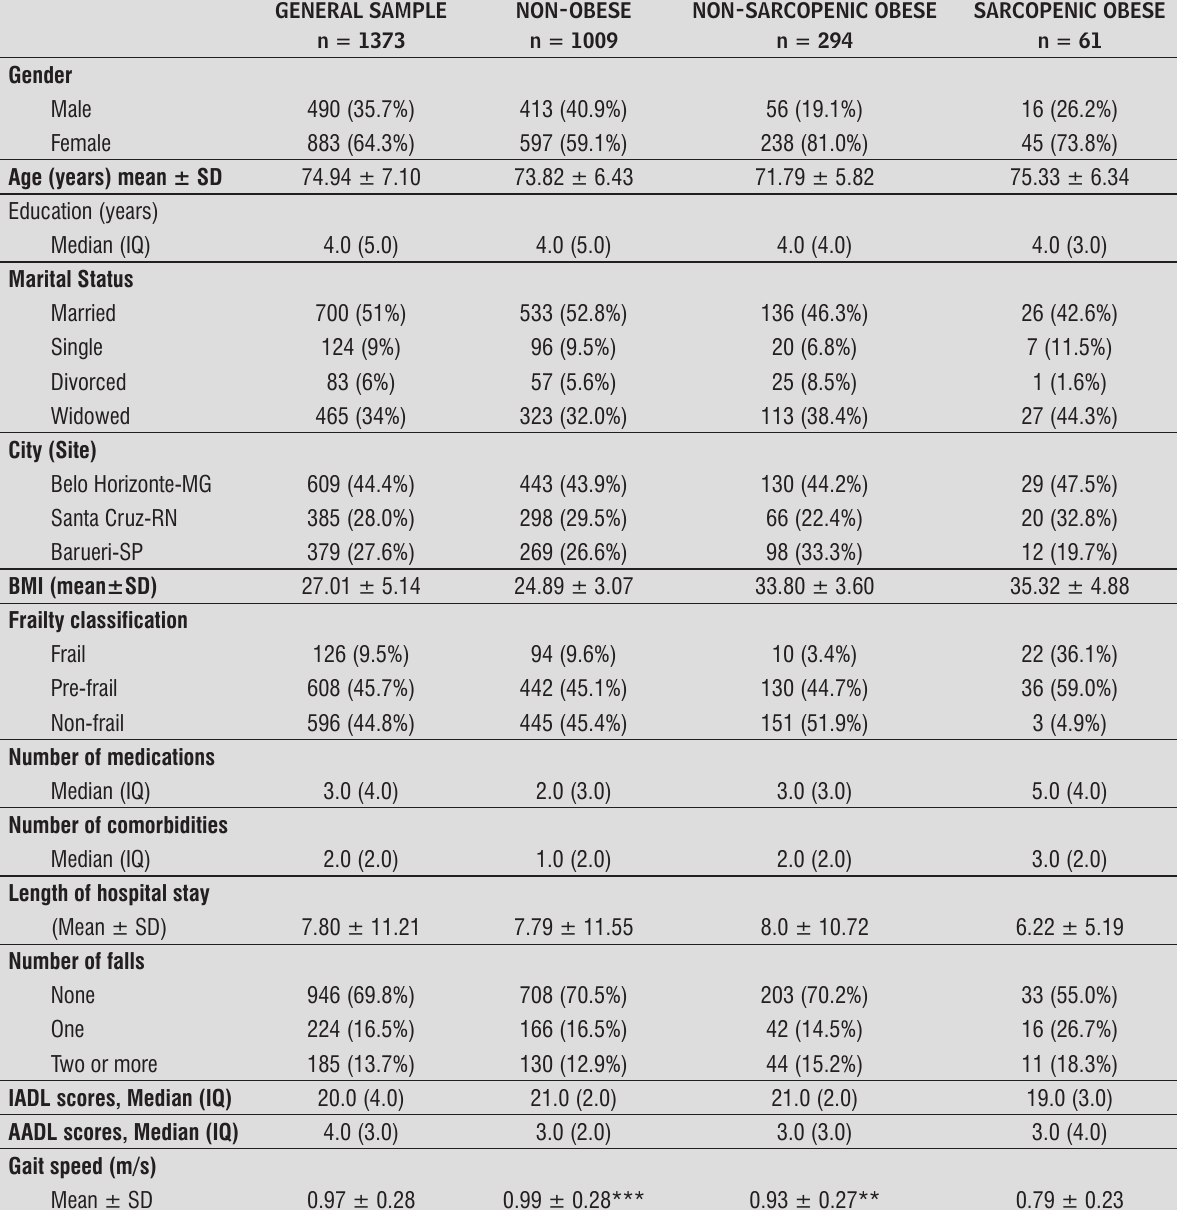
Table 1 - Sociodemographics, health conditions and functional performance of the